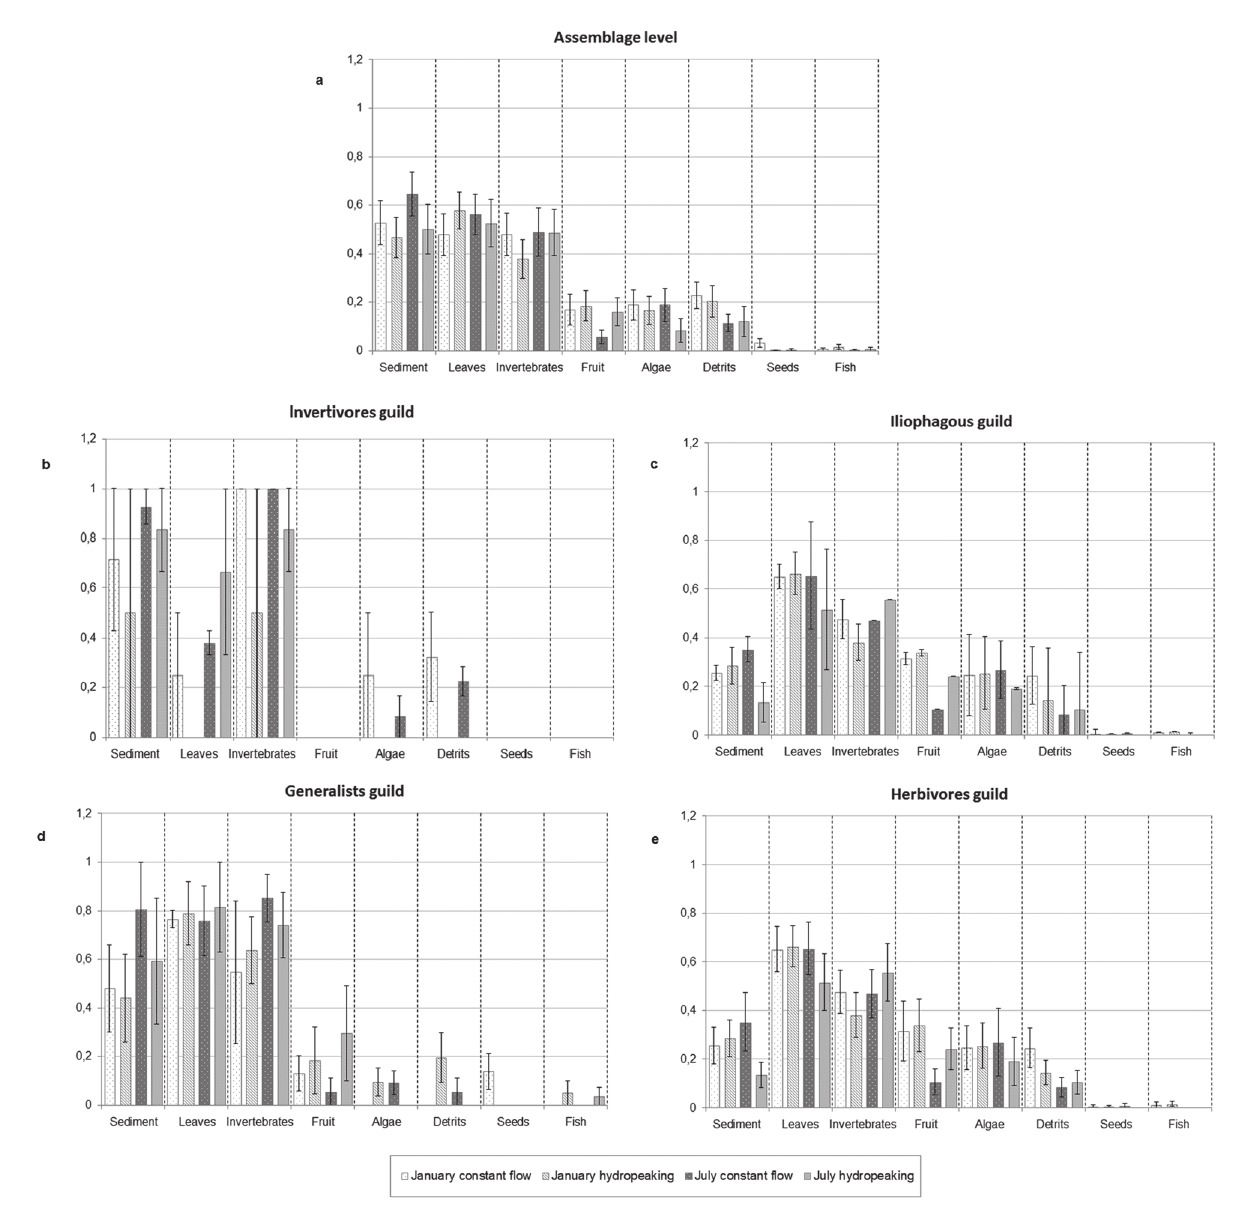
Fig. 3. Average frequency of occurrence of food items in the analyzed treatments based on SIMPER analysis, downstream from Itutinga Dam, Grande River. a - Assemblage level; b - Invertivores guild; c - Iliophagous guild; d - Generalists guild; e - Herbivores